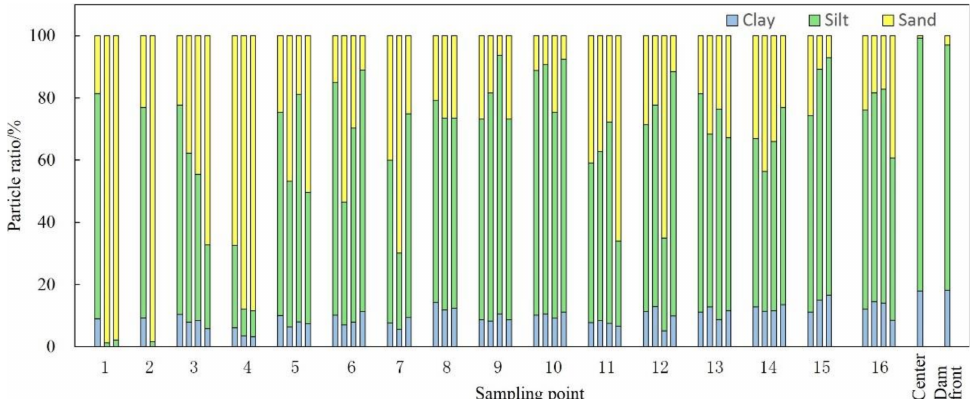
Figure 4. Sediment composition and peak number at each point in Dapu.